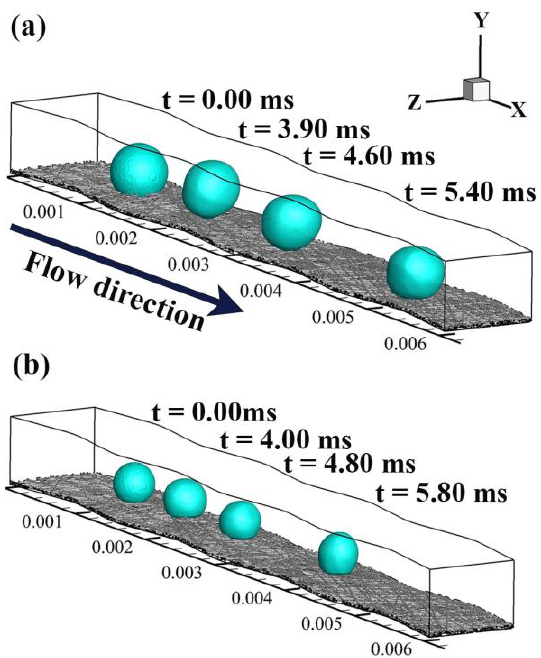
Figure 11. Temporal droplet evolution under similar operating conditions with different droplet sizes ( a ) 200 µm and ( b ) 150 µm.